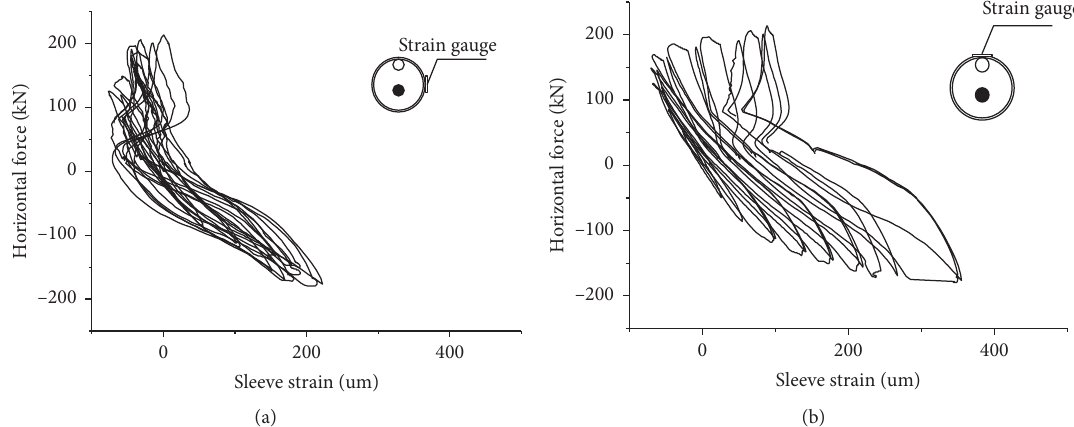
Figure 22: Hysteresis curves for transverse strains of type-I sleeve in YZ1. (a) Strain gauge away from the rebar (SG15). (b) Strain gauge near the rebar